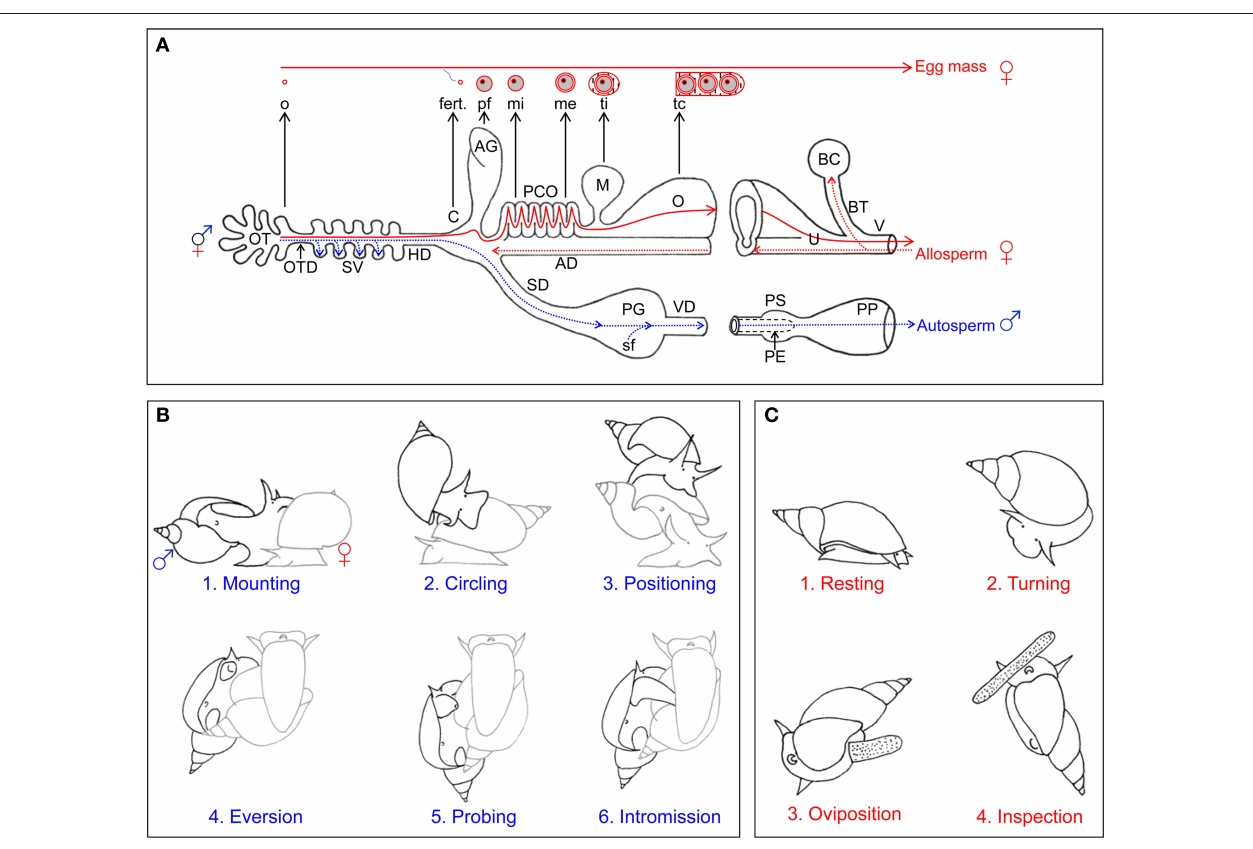
courtship and insemination behavior. Copulation starts with mounting (1) on the shell. For some 5 min, the sperm donor then performs counterclockwise circling (2), first toward the shell’s tip and then toward its margin. It then takes on average 17 min from positioning (3) to intromission (4), during which eversion of and probing (5) with the preputium occur. Once intromission (6) is reached, an average insemination takes 35 min. The sperm donor is displayed in black, the sperm recipient in gray. (C) Egg-laying behavior. The drawings show the different stages of female reproductive behavior, i.e., egg laying. The behavior is redrawn from Ter Maat et al. (1987). Egg laying starts with a resting phase (1) of on average 40 min, during which locomotion stops, the shell is held still and slightly pulled forward over the tentacles and no rasping occurs. During the turning phase (2), lasting around 60 min, locomoting starts again, the shell is turned back and forth by 90 ° and the surface is rasped. Oviposition (3) usually lasts about 10 min during which the animal continues rasping, but stops shell turning and hardly moves. During inspection (4) the animal crawls along the mass for up to 30 min without rasping or shell turning. The panels are adapted from Jarne et al.